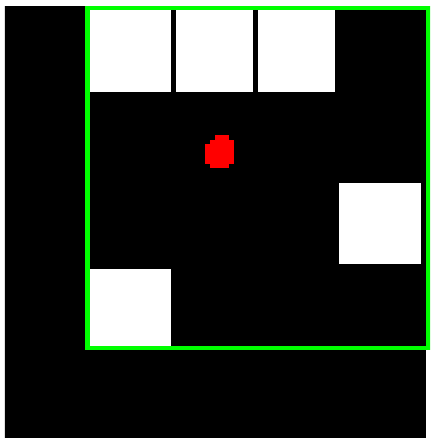
Figure 7. The centroid (red dot) and the bounding box (green box) of the discontinuous region of interest (ROI).